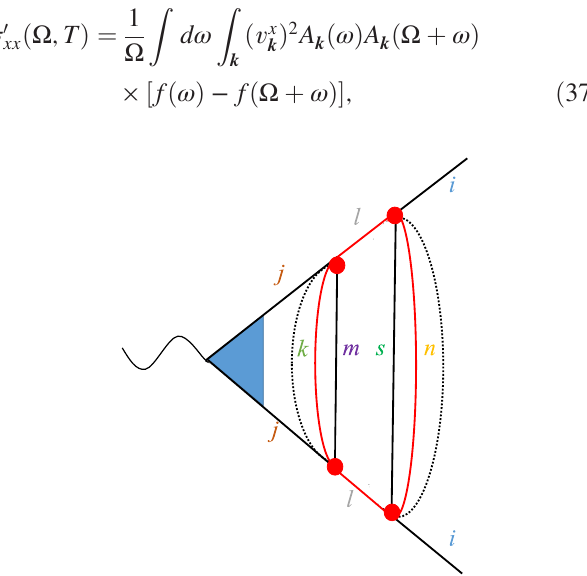
FIG. 6. Correction to the current vertex in Fig. 5(b) at the same order in 1 =N